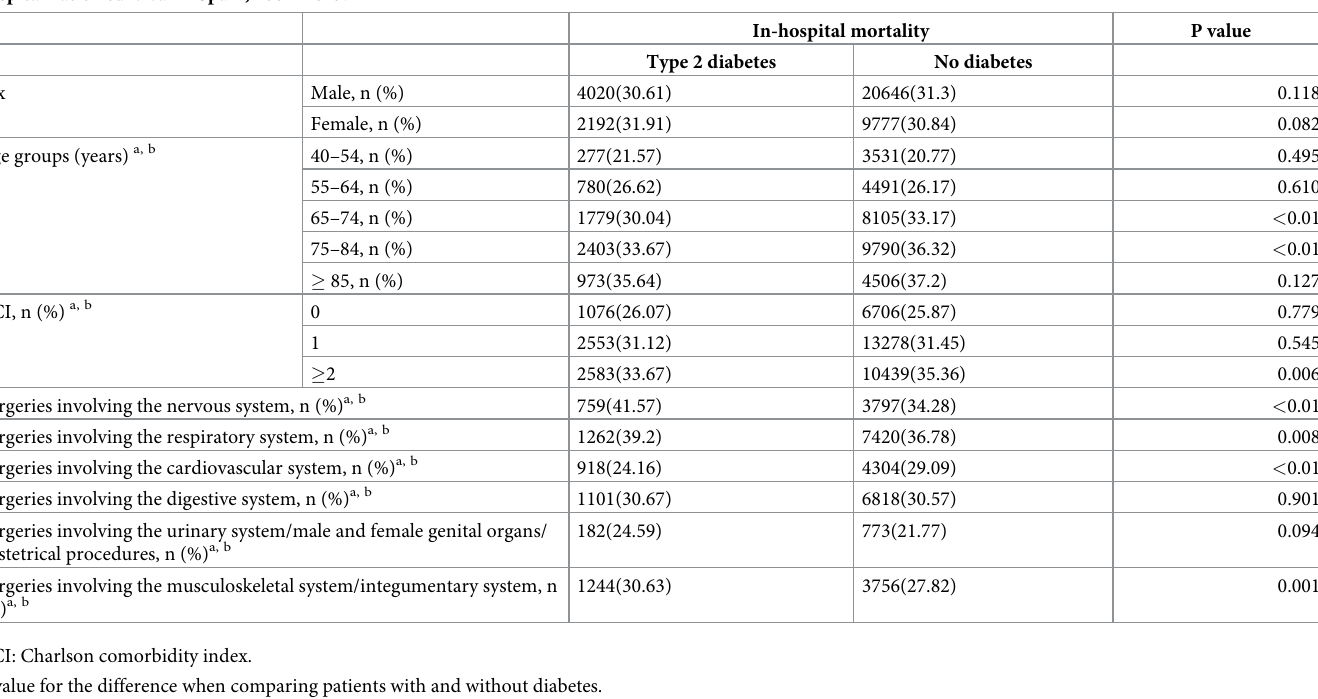
Table 3. Sociodemographic and clinical characteristics of hospitalized patients with and without diabetes who suffered from postsurgical pneumonia according to hospitalization survival in Spain,